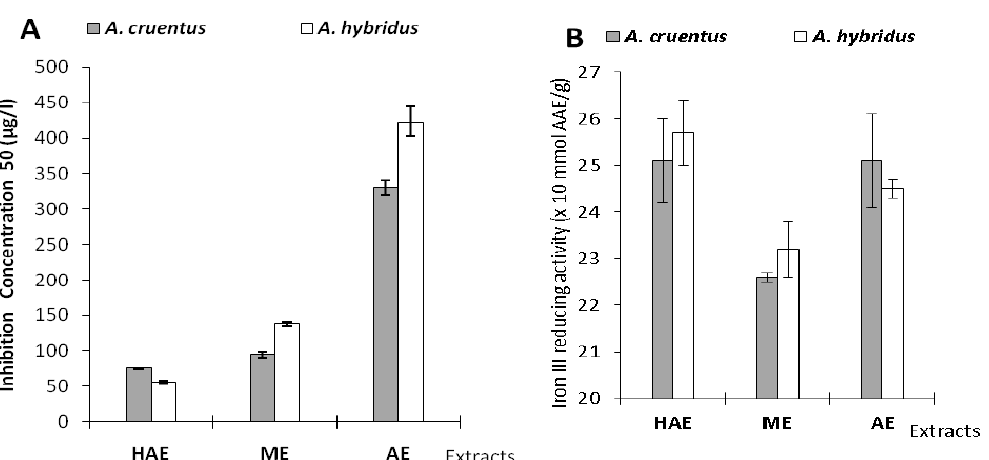
Figure 3. Results of in vitro antioxidant assays. A : Free radical scavenging activity represents by IC . B : Antioxidant activity of extracts in FRAP 50